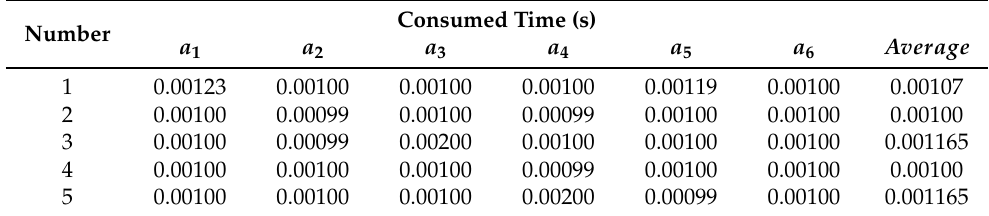
Table 1. Consumed time to output an action by the